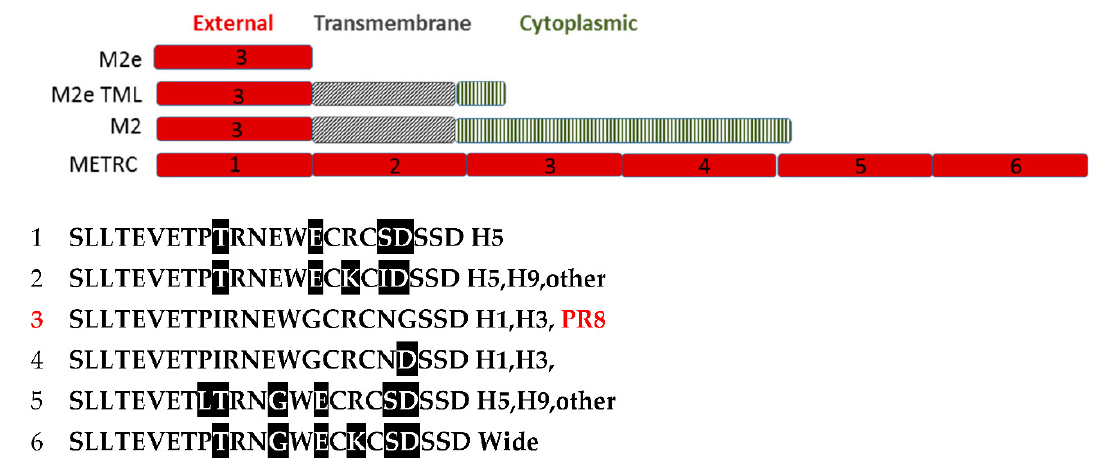
Figure 1. Influenza matrix protein M2 structural features and comparison to METRC used in this study. M2e domains (red in diagram) are the external 23 amino acids of the M2 molecule. An M2e TML construct contained M2e from PR8 H1N1 and a conserved transmembrane region with an additional 16 cytoplasmic amino acids for a total of 58 amino acids. The M2 molecule in nature consists of an external domain (red, M2e), a transmembrane domain (slashes, grey), and a cytoplasmic domain (lined, green) for a total of 97 amino acids. METRC contains 6 versions of M2e domains (red), each found in nature. Amino acid sequences of each version of M2e found in METRC are listed with amino acid substitutions relative to peptide #3 which is native to PR8.